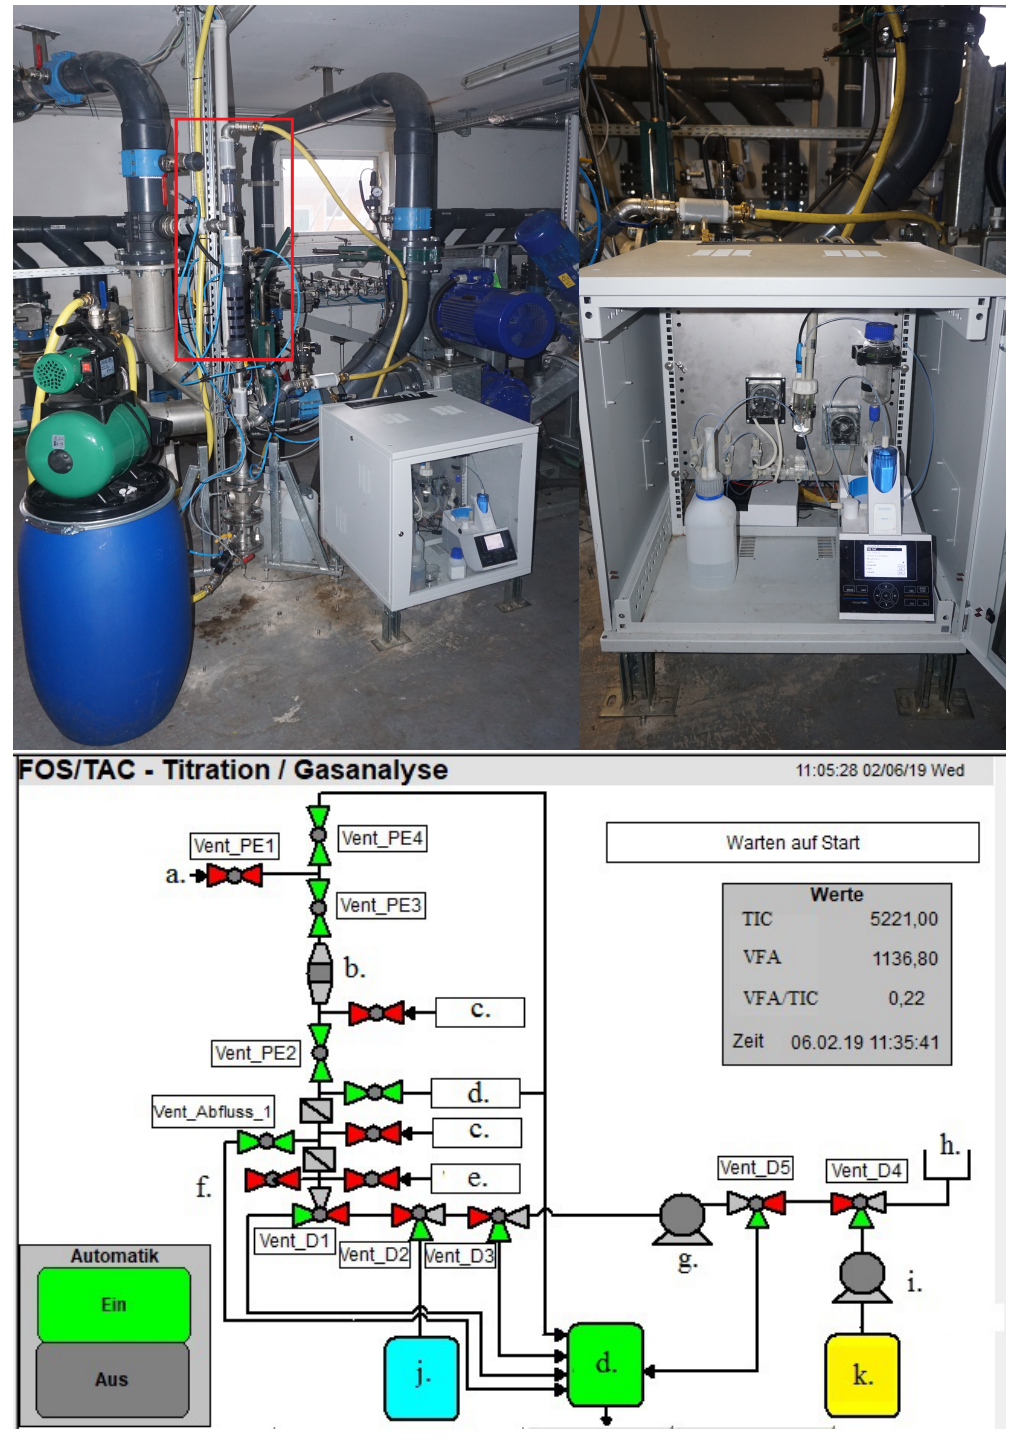
Figure 4. Above left: Sampling system installed at the research plant. Marked sample collection. Above right: Dosing unit and titrator. Below: Visualization for the operator (key: a. Connection pump manifold; b. Collecting Tank; c. Pressure air; d. Drain; e. Watter; f. Venting; g. Peristaltic dosing pump; h. Titration cell; i. Peristaltic pump; j. Distilled water; k.